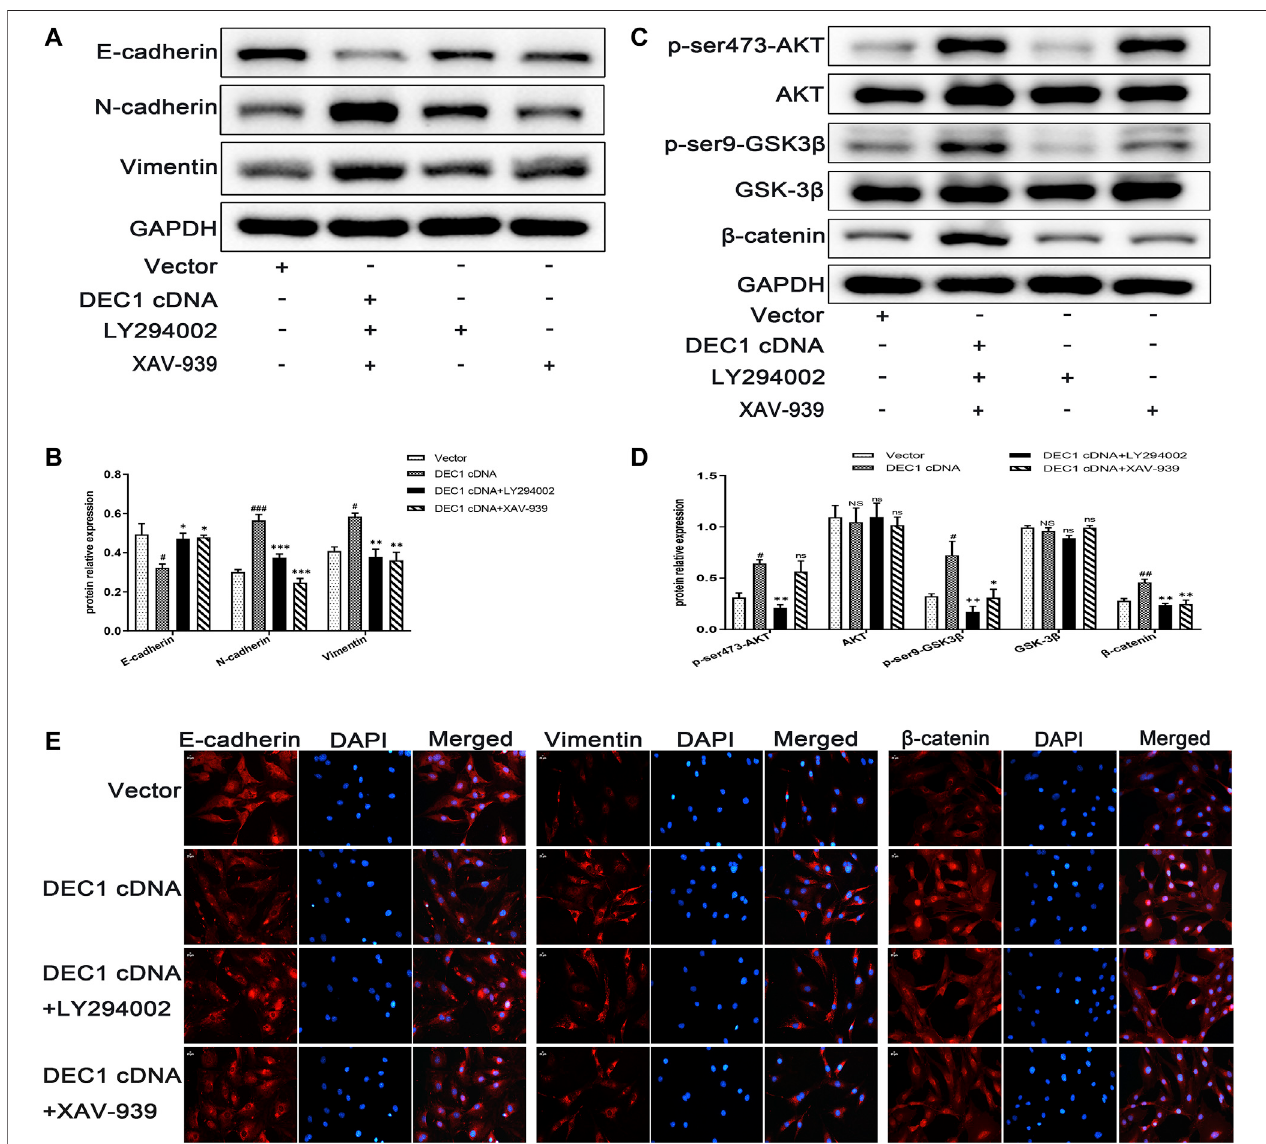
FIGURE 10 | DEC1 overexpression induces EMT and activates the PI3K/AKT/GSK3 β / β -catenin signaling pathway in A549 cells. A549 cells were treated with LY294002 or XAV-939 for 1 h prior to the transfection with DEC1 overexpression plasmids. (A) The protein expression of E-cadherin, N-cadherin and Vimentin in A549 cells were measured by western blotting. (B) Statistical analysis of relative expression levels of proteins in A. (C) The protein expression of p-ser473-AKT, AKT, p-ser9- GSK3 β , GSK-3 β , and β -catenin in A549 cells were measured by western blotting. (D) Statistical analysis of relative expression levels of proteins in C.